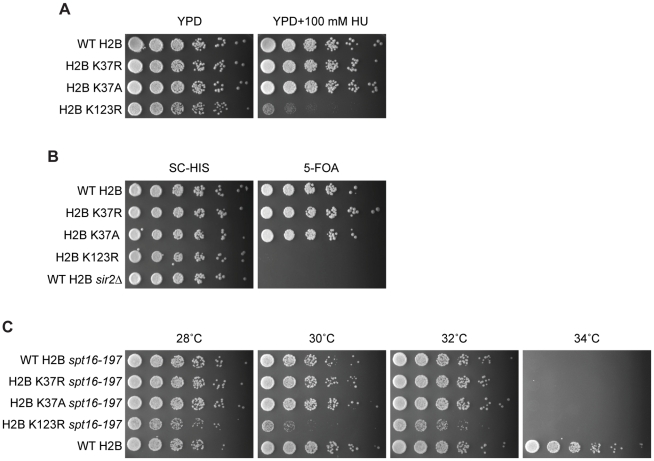
Phenotypic analysis of strains harboring H2B K37R/A mutations.(A) Phenotypic spotting assays indicate that cells harboring mutations at lysine 37 in histone H2B to arginine (YKG006) or alanine (YKG007) do not show sensitivity to YPD media containing 100 mM hydroxyurea (HU; a DNA damaging agent that leads to replication fork collapse), as is observed in an H2B K123R mutant strain (YKG002) [101], but rather grow similarly to yeast containing wild-type H2B (YKG001). (B) Telomeric silencing assay demonstrates that reporter strains harboring H2B K37R and H2B K37A mutations (YKG028 and YKG029, respectively) exhibit normal silencing like that observed for reporter strains expressing wild-type H2B (YKG027), but not strains that express an H2B K123R mutation (YZS274) or are deleted for SIR2 (YZS275), which have known defects in telomeric silencing [48]. Growth on SC-HIS serves as a plating control, as all strains express H2B-containing plasmids carrying a HIS3 auxotrophic marker. (C) Introduction of H2B K37R or K37A mutations (YKG033 and YKG034, respectively) into strains containing a temperature-sensitive allele of SPT16 (spt16–197) does not affect cellular growth at the semi- and non-permissive temperatures (32°C and 34°C, respectively), as cells grow at a similar rate to those harboring wild-type H2B (YKG031). Introduction of an H2B K123R mutation (YKG032) exacerbates growth in the spt16–197 background at the semi-permissive temperature, in agreement with previously published results [102]. The isogenic parental strain Y131 expressing wild-type SPT16 grows phenotypically normal at the non-permissive temperature for the spt16–197 strain.